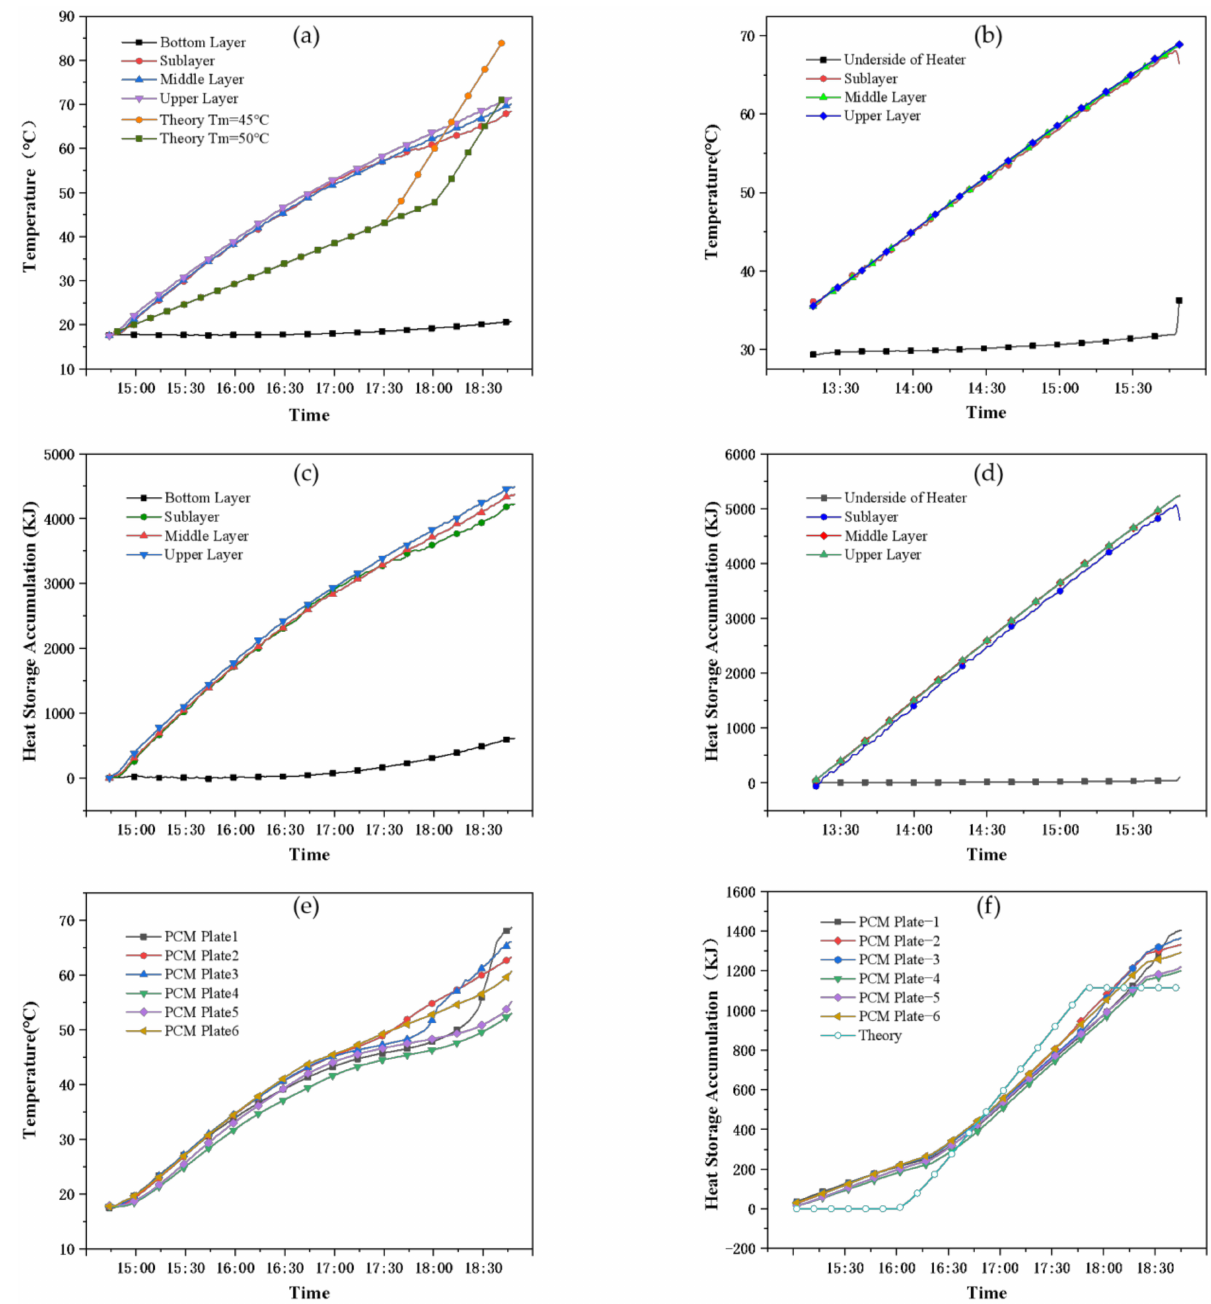
Figure 6. In working condition 1: ( a ) Water temperature curve of the PCM storage tank; ( b ) Water temperature curve of the common tank; ( c ) Heat storage accumulation curve of the PCM storage tank; ( d ) Heat storage accumulation curve of the common tank; ( e ) Temperature curve of the PCM plate; ( f ) Heat storage accumulation curve of the PCM